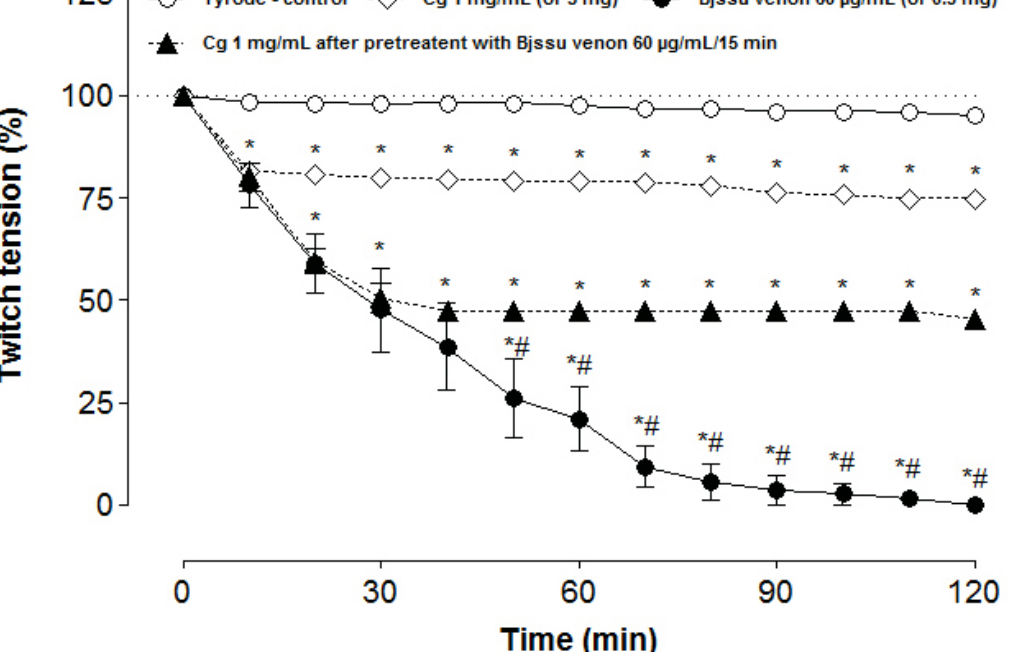
Figure 5. Twitch tension of mouse isolated phrenic nerve-diaphragm preparations under indirect stimuli, in percentage (each point represents the mean ± SEM, n = 6). Post-treatment of preparations with 1 mg/ mL (or 5 mg) Cg hydroalcoholic extract after 15 minutes, followed by 60 μg/mL (or 300 mg or 0.3 mg) Bjssu venom addition. * p < 0.05 compared to Tyrode control for all periods (except 0). # p < 0.05 compared to treatment with Bjssu during 15 minutes, followed by Cg extract